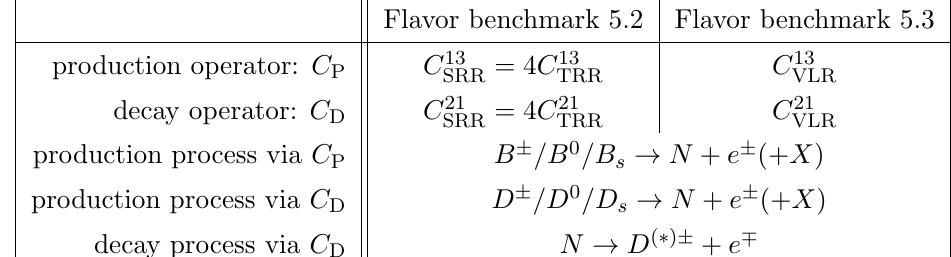
Table 7 . Summary of (cid:13)avor benchmark 5.